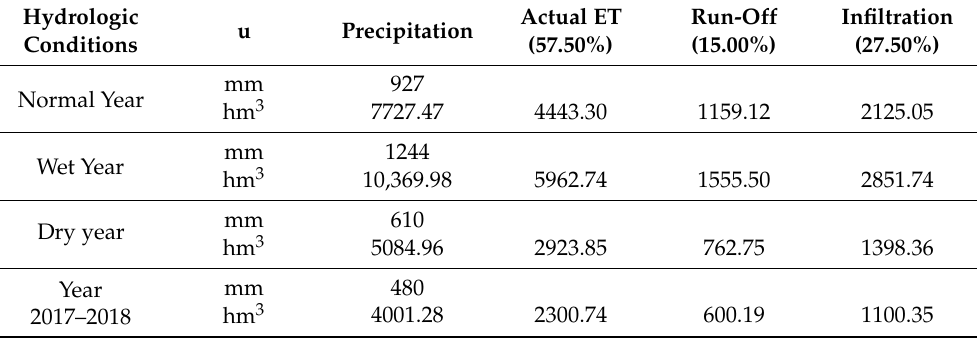
Table 1. Average annual values of the hydrologic circle of Crete a (average values in mm and in hm 3 ) (adapted from